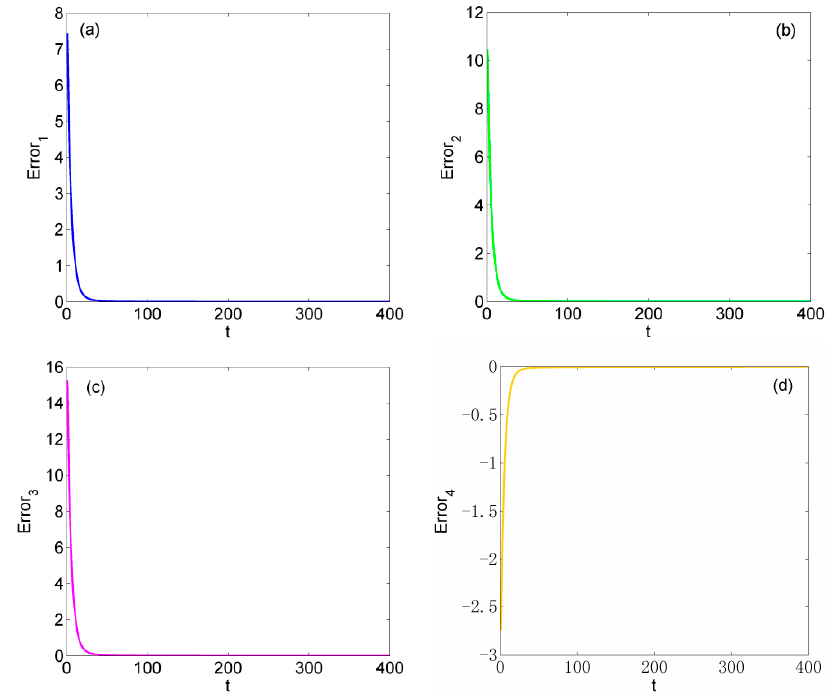
Figure 6. Evolution of error curves of system (15). ( a ) The blue line means Error 1; ( b ) The green line denotes Error 2; ( c )The pink line is Error 3; ( d ) The yellow line is Error 4 . Case 2. Generalized linear synchronization.